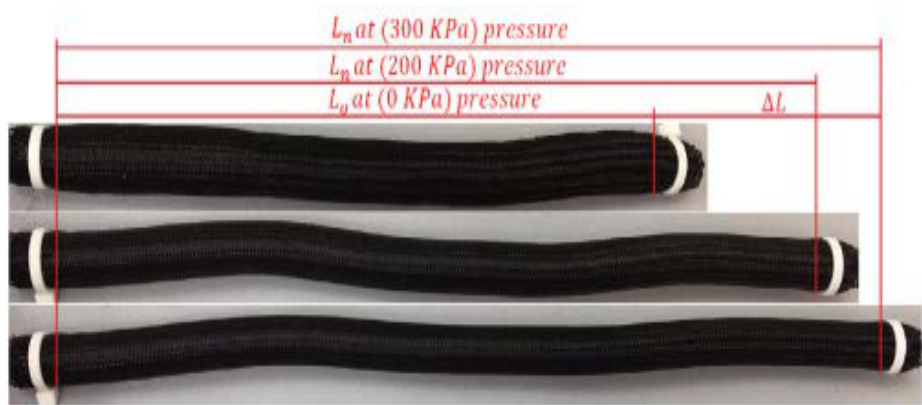
Figure 14. PAMs with different pressures, where L 0 is the muscle length without being pressurized, L n is the muscle length under pressure, and (cid:52) L is the increase in length (Reprinted with permission from Al-Fahaam, H. et al. [112]. Copyright (2018), with permission from Elsevier).